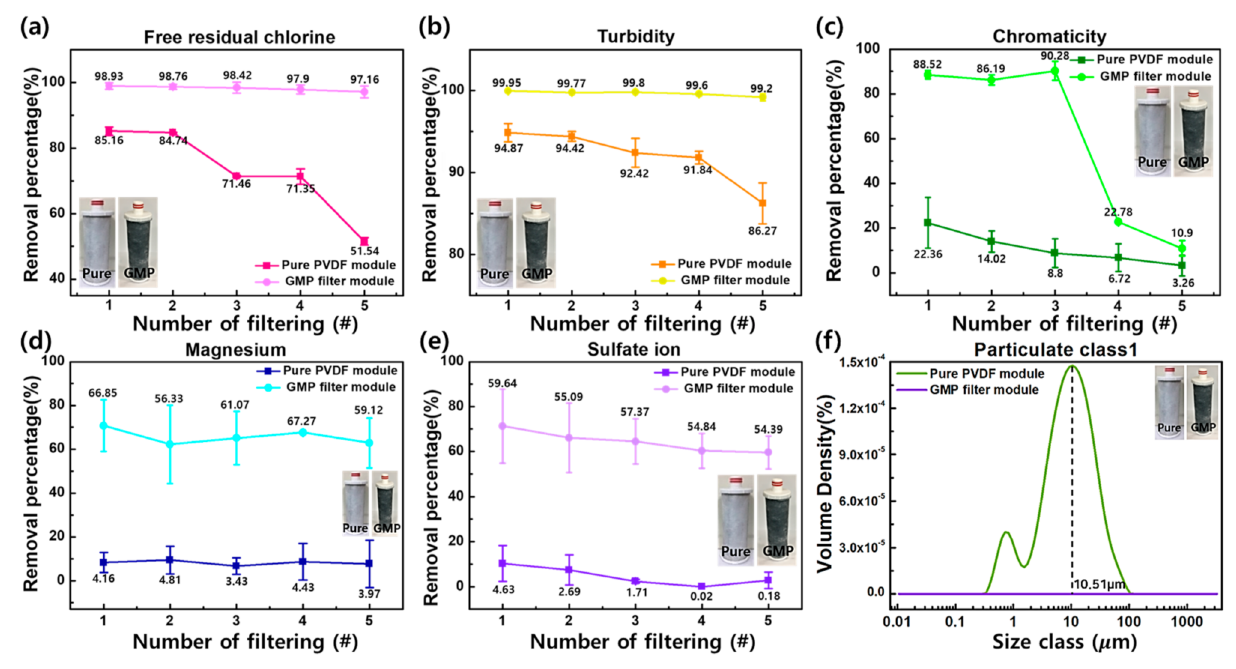
Figure 4. Comparative analysis of pure PVDF module and GMP module for ( a ) free residual chlorine, ( b ) turbidity, ( c ) chromaticity, ( d ) magnesium, ( e ) sulfate ion, and ( f ) particulate class1,